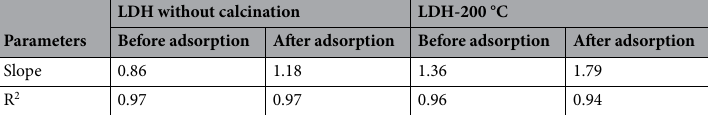
Table 4. The slope and correlation factor in the anodic current densities ( I a ).